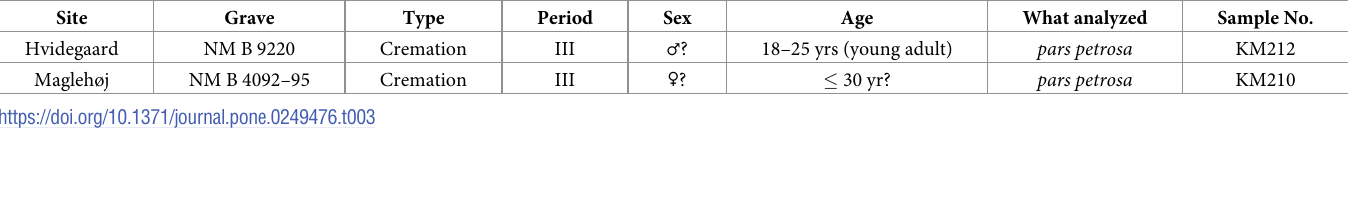
Table 3. Details of material sampled from Early Nordic Bronze Age Zealand.